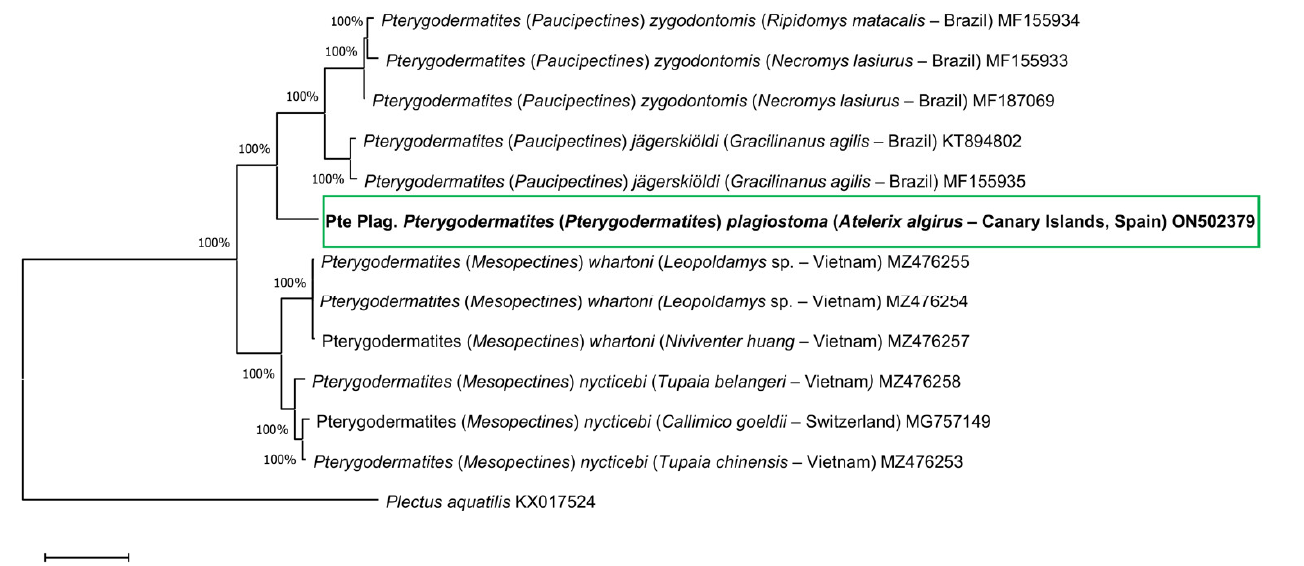
Figure 1. Phylogenetic analysis using the Maximum Likelihood method with p-distance and 1000 bootstrap replications based on the MT-CO1 gene sequences exploring the relationships among Pterygodermatites species including the nucleotide sequences obtained in this study (shown in bold). Plectus aquatilis was used as the outgroup.